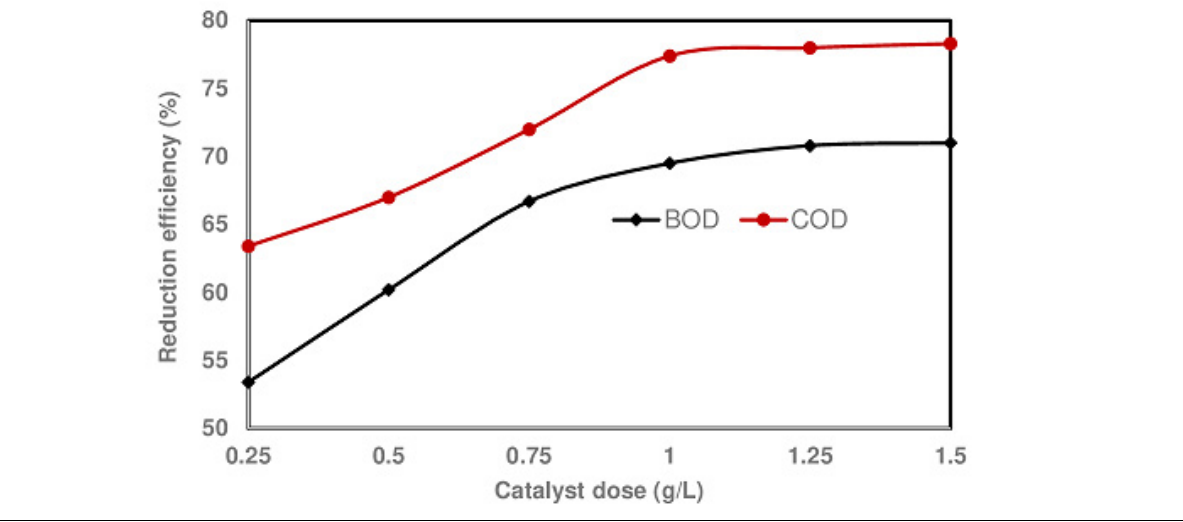
Figure 4: Effect of catalyst dose on the reduction efficiency of biological oxygen demand (BOD